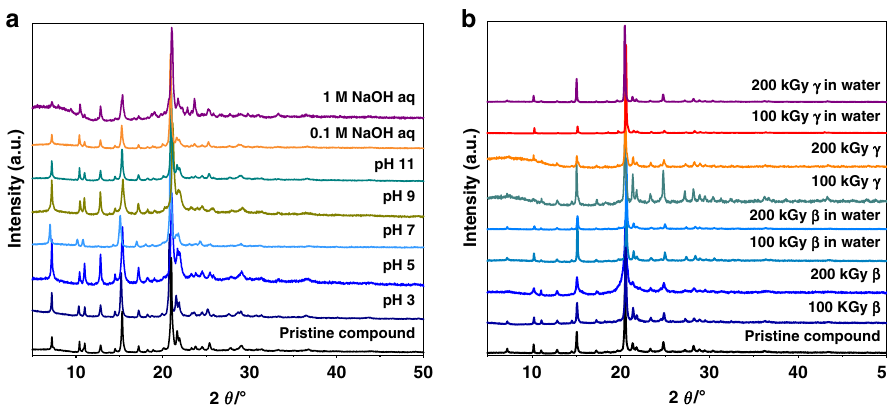
Fig. 2 Powder X-ray diffraction of SCU-103. a PXRD patterns of SCU-103 after immersion in aqueous solutions with different pH values ranging from 3 to 14. b PXRD patterns of SCU-103 after β and γ